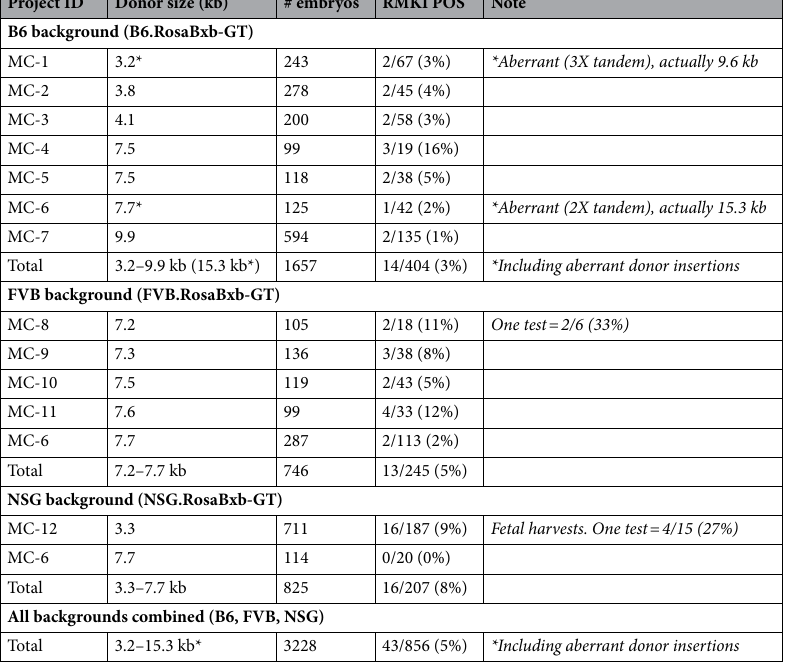
Table 2. Summary of RMKI attempts.